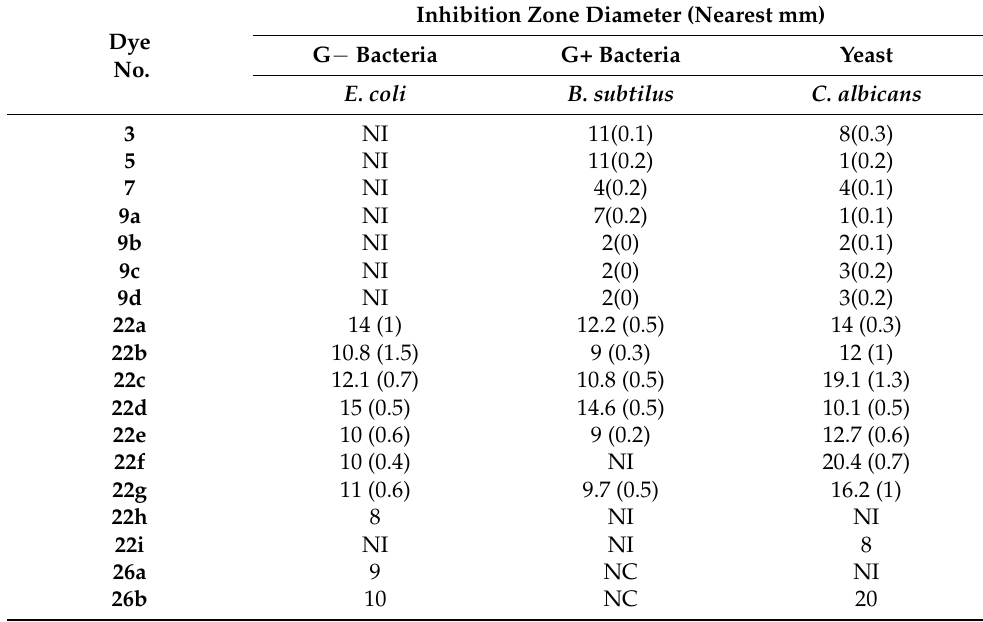
Table 5. Inhibition zones of dyes 3, 5, 7, 9a-d, 22a–i and 26a,b.